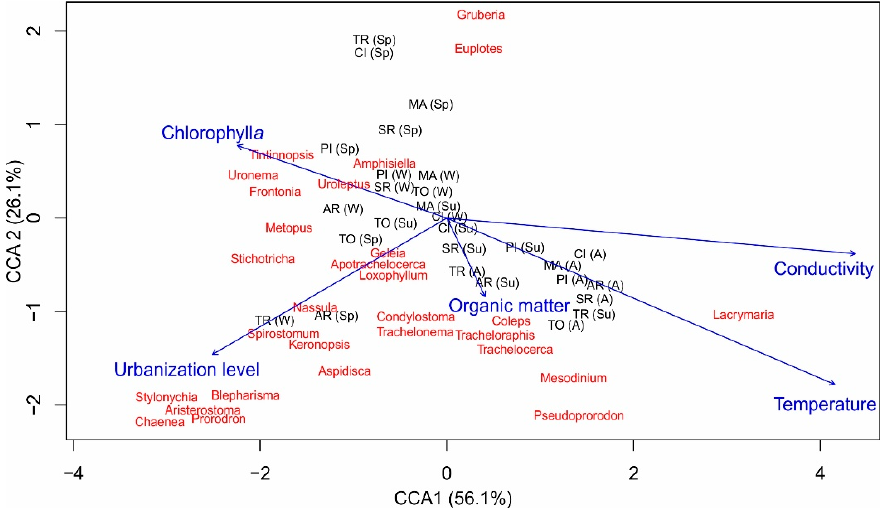
Figure 8. Ordination scatter plot obtained from a constrained correspondence analysis (CCA) of the benthic ciliate community. Ciliate taxa in red, environmental variables in blue, and sampling units in black. Sampling unit labels comprise site (AR: Arroio do Sal, CI: Cidreira, MA: Magistério, PI: Pinhal, SR: Santa Rita, TO: Torres, TR: Tramandaí) followed by season (Sp: Spring, Su: Summer, A: Autumn, W: Winter).